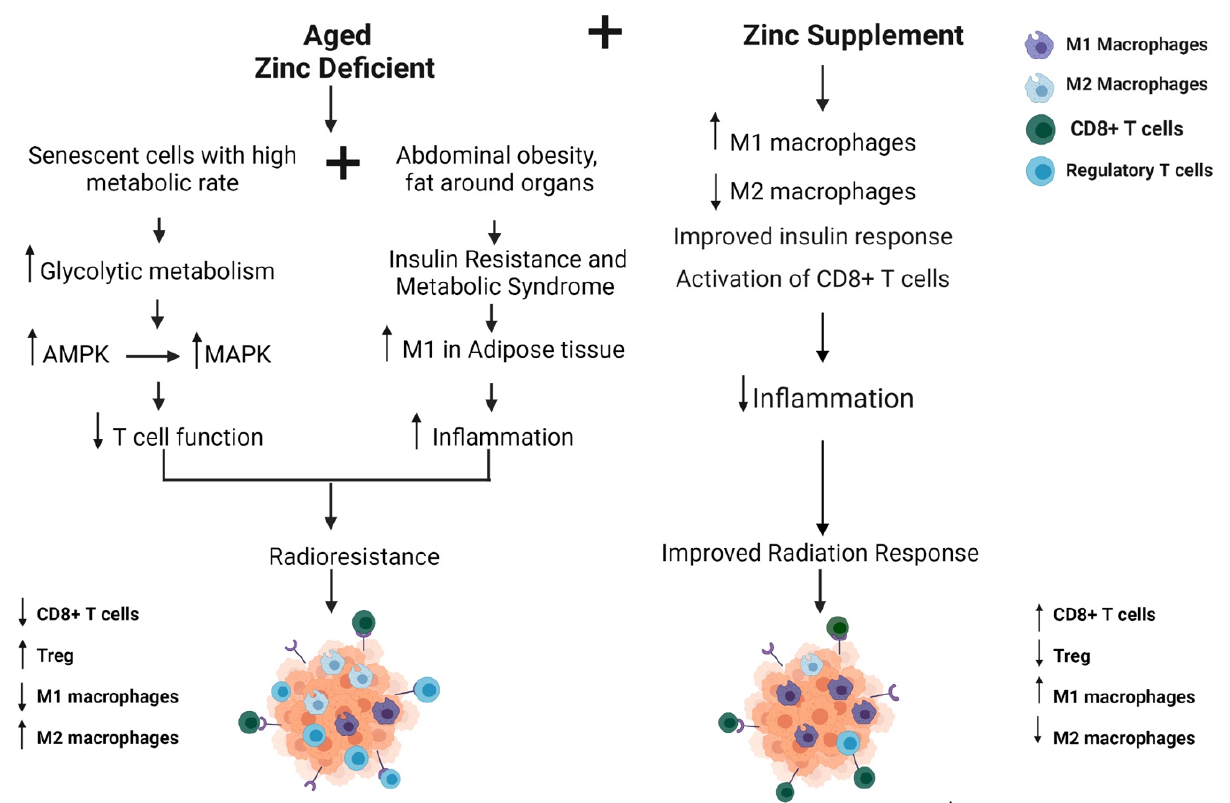
Figure 3. Zinc supplementation to modulate antitumor immune response and radiation sensitivity in the senior adult breast cancer patient. Older women show abdominal obesity and insulin resistance with inflamed adipose tissue and possess senescent cells that show elevated glycolytic metabolism, leading to reduced T-cell function and immunosuppression. Zinc deficiency is commonly observed in older women. Modeling supplementation with Zinc, radiation response would be improved by reducing inflammation and improving insulin and immune response, thereby reducing breast cancer tumor growth [108,117,121]. Created with